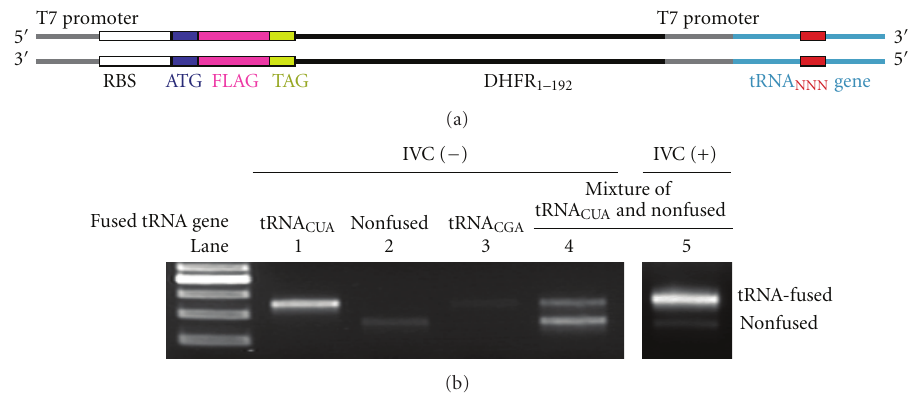
Figure 1: (a) Schematic sequence of the tRNA-fused template with two T7 promoters. The triple N in red represents the anticodon- or anticodon-loop-randomized region. (b) Agarose gel electrophoretic assay of the template DNAs recovered from tRNA CUA -fused template (lane 1), nonfused template lacking the tRNA domain (lane 2), a 1:1 mixture thereof (lanes 4, 5), or tRNA CGA -fused template (lane 3), after coupled transcription/translation under normal (noncompartmentalized) (lanes 1–4) or compartmentalized (lane 5) conditions.